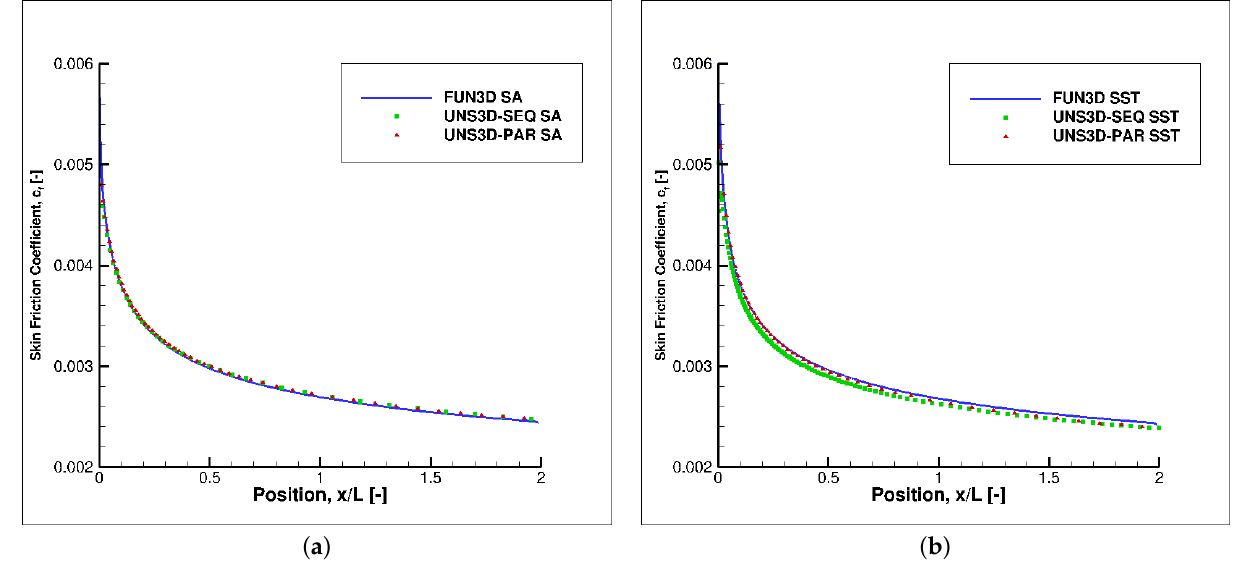
Figure 8. Skin friction coefficients for turbulent flat plate: ( a ) Spalart–Allmaras, and ( b ) Shear Stress Transport. Figure 9 shows the predicted velocity profiles at two x / L locations: 0.97 and 1.90. The results generated with the UNS3D-SEQ, UNS3D-PAR, and CFL3D codes agree well, for both the Spalart-Allmaras and the Shear Stress Transport models.